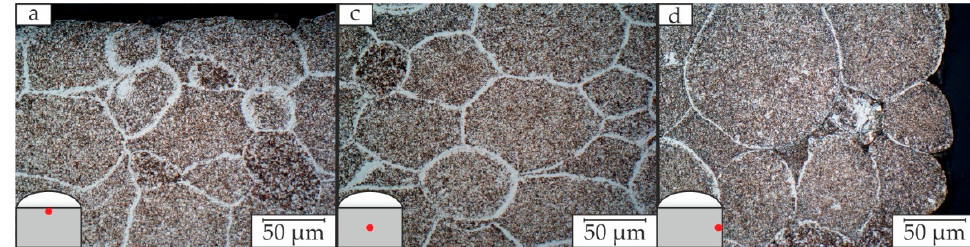
Figure A5. Microstructure in defined positions a, c and d according to Figure 1 (right) of a TNM sample sintered at 1150 °C, with 10 min dwell time and 65 MPa pressure.